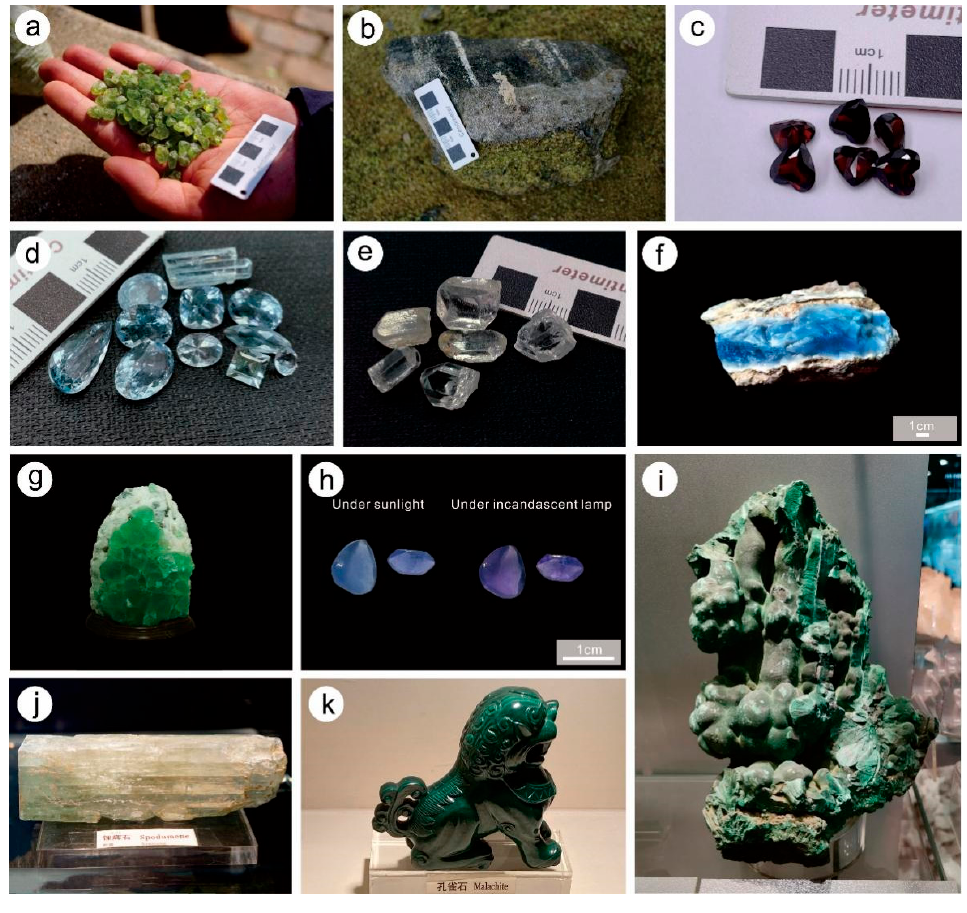
Figure 4. ( a ) The high-quality olivines from Damaping, Hebei province. ( b ) The peridotite xenoliths in basalt, ca. 12 cm. ( c ) The red pyropes from Maguan, Yunnan province, have high color saturation and good transparency. ( d ) The high-quality aquamarine from Xinjiang province. ( e ) The topaz from Yunnan province with good crystal shape and high transparency. ( f ) The blue opal from Lishui, Zhejiang province. ( g ) The Fluorites from Fujian province intergrowth with calcite. ( h ) The color- changing fluorite from Hebei province. ( i ) The Guangdong malachite has villous crystals and occurs as botryoidal aggregate. ( j ) Spodumenes from Xinjiang can develop into giant crystals with perfect crystal shapes. ( k ) The high-quality malachite carving from Guangdong province with typically peacock green and banded color zonation. (Figure 4g–k are collected in the Geological Museum of China).